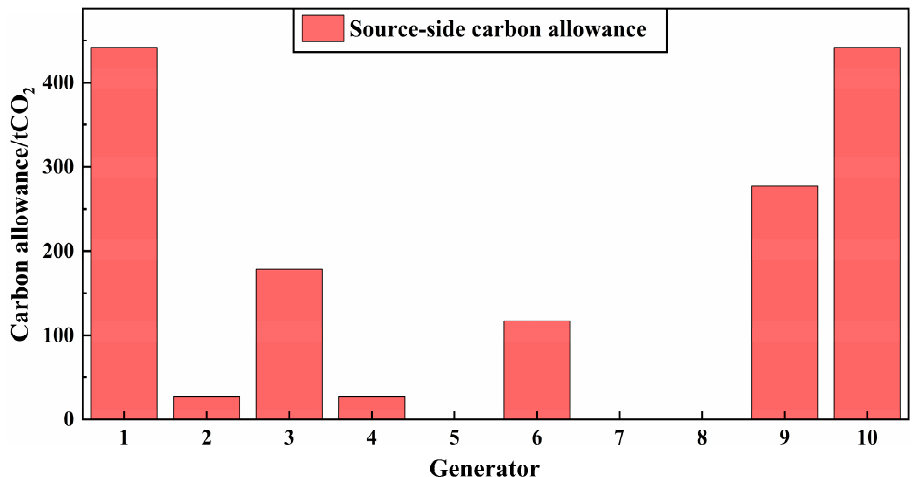
Figure 5. Carbon allowance values of 10 generators.